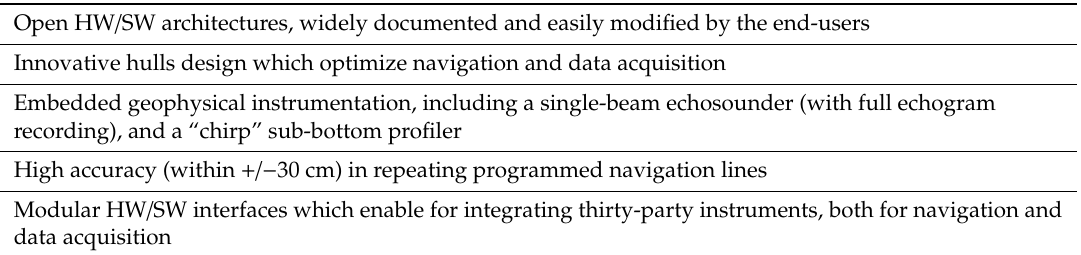
Table 1. Main characteristics of the OpenSwap vehicles.